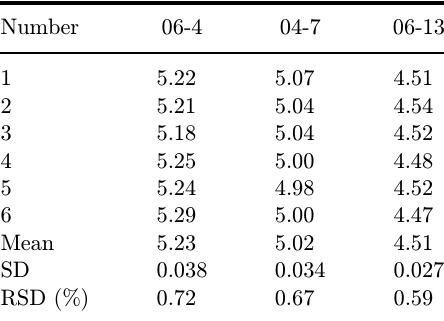
Table 5. The results of the repetitive